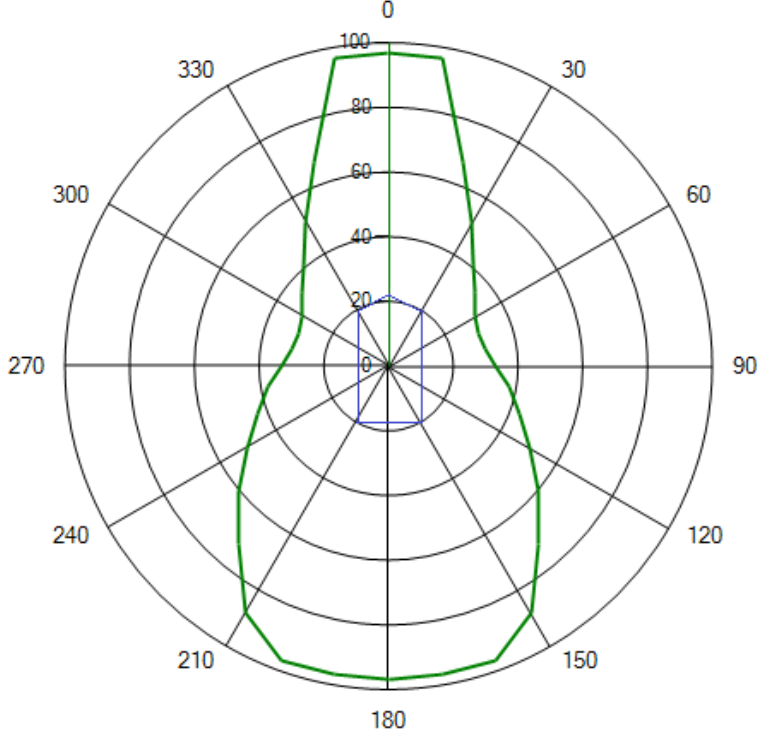
Figure 4. The result of the capability plot analysis for a conventional positioning